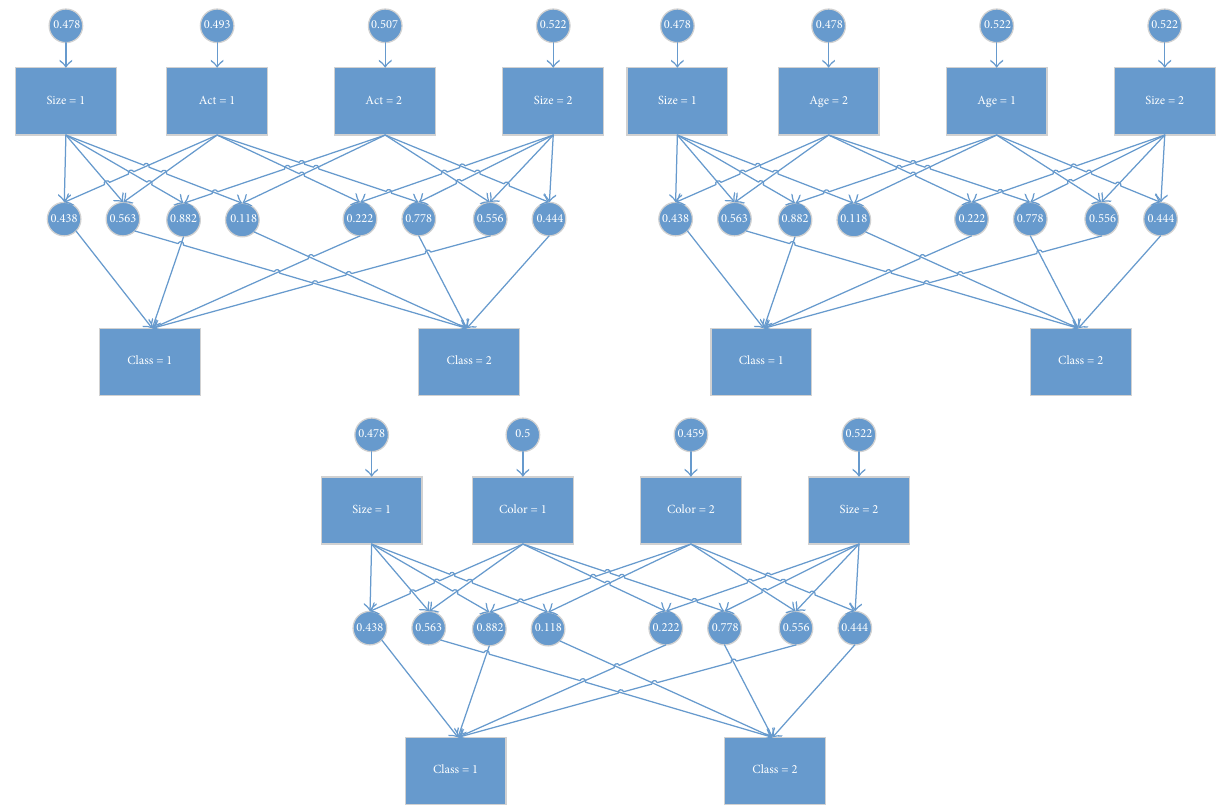
Figure 6: Balloon dataset three-part BKBs.